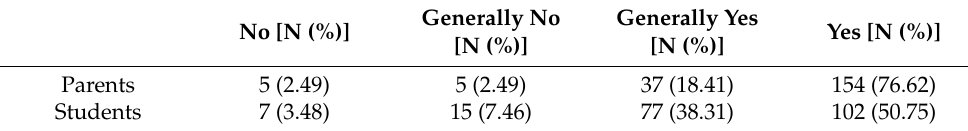
Table 7. Wearing of protective masks when obligatory.